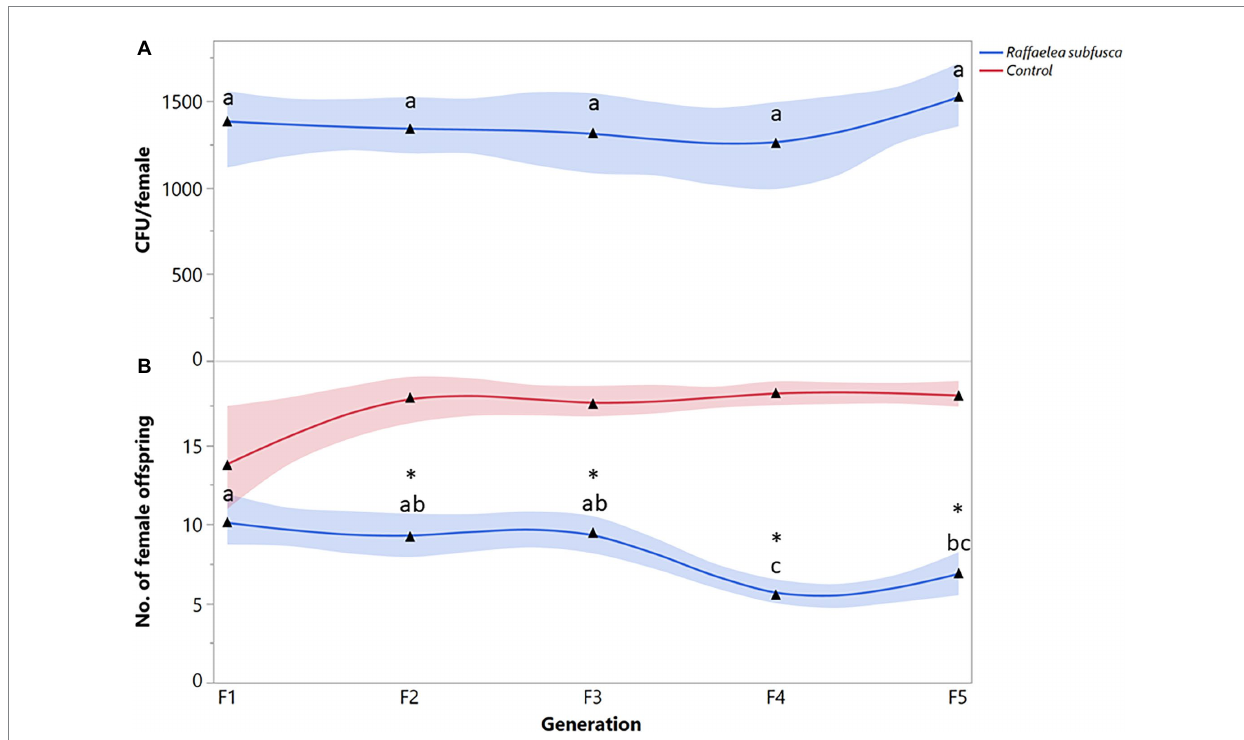
FIGURE 2 Xyleborus bispinatus performance with a single mutualistic fungus ( Raffaelea subfusca ). (A) Mean number of CFUs ( ▲ ) recovered from single female offspring per generation and (B) Mean number of female offspring ( ▲ ) produced by single female founder per generation. Same letters within the same color are not significantly different (Tukey HSD, α = 0.05). Asterisks show significant differences in female offspring between fungal symbiont and control within generation (Kruskall-Wallis, α =